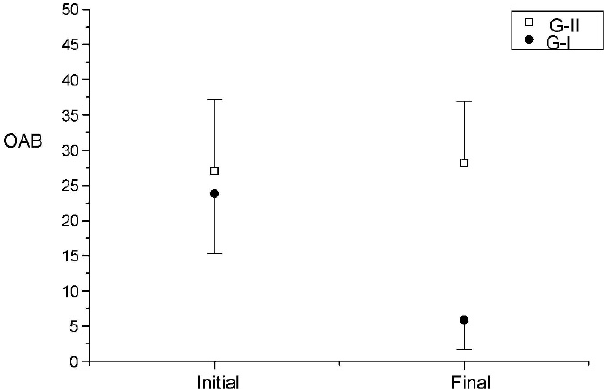
Figure 2 - The mean and standard deviation of the OAB-V8 before and after the intervention in treatment (GI) and sham (GII) groups. Mean: 23.84 initial and 5.92 final in GI; 27.14 initial and 28.21 final in GII ( p ,